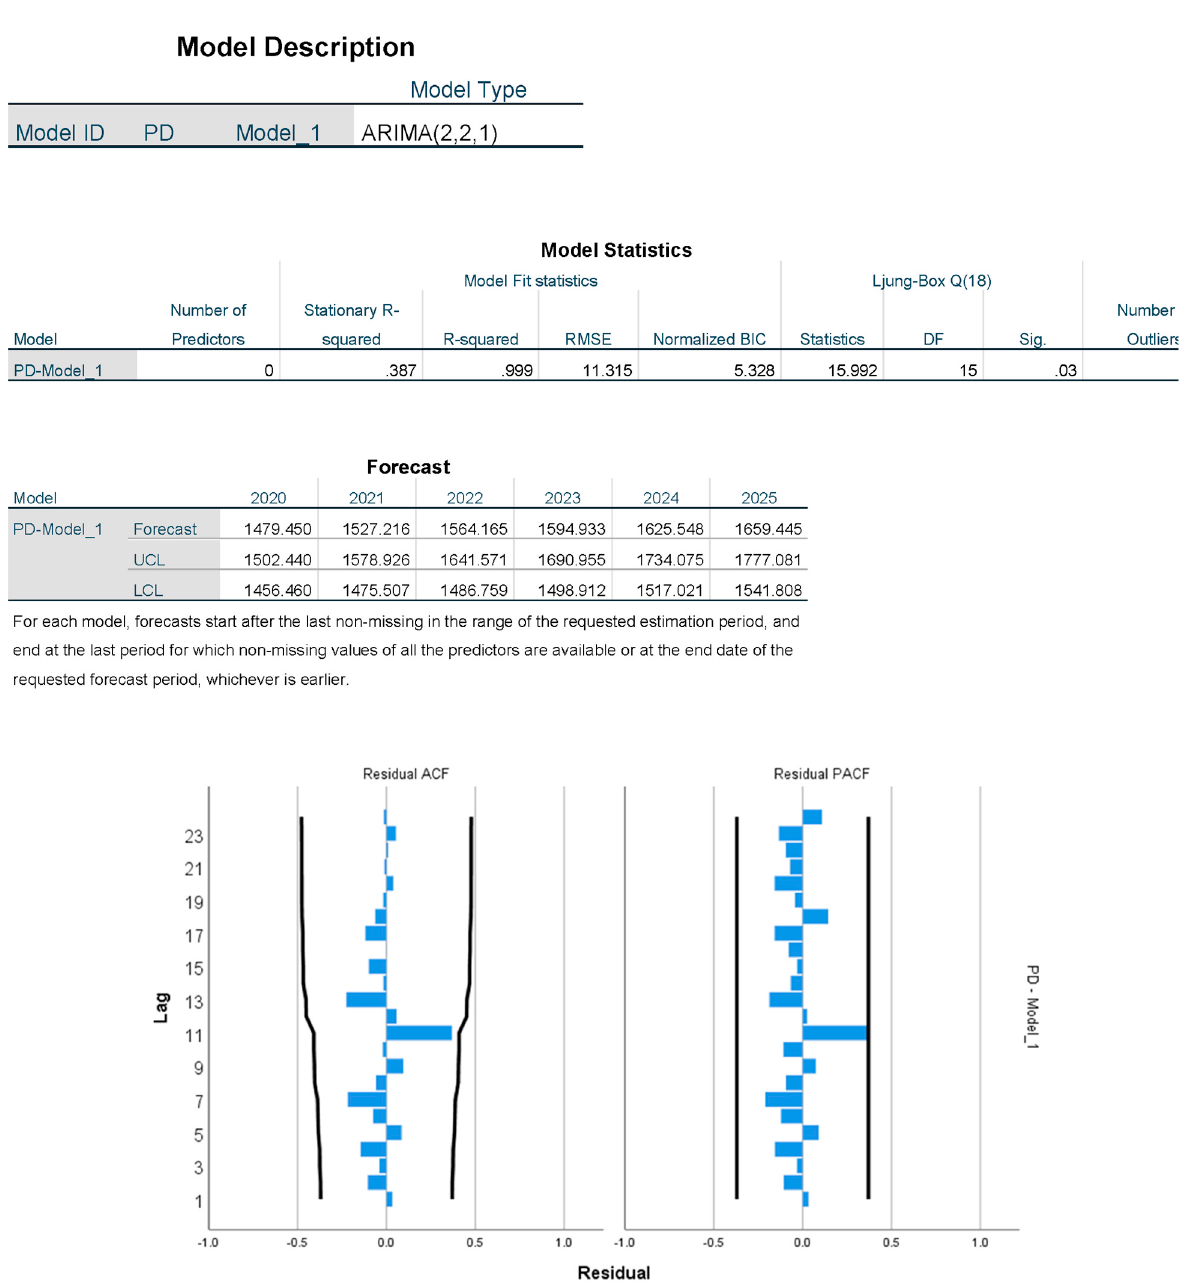
Figure A5. Model (1): forecast in premature deaths.